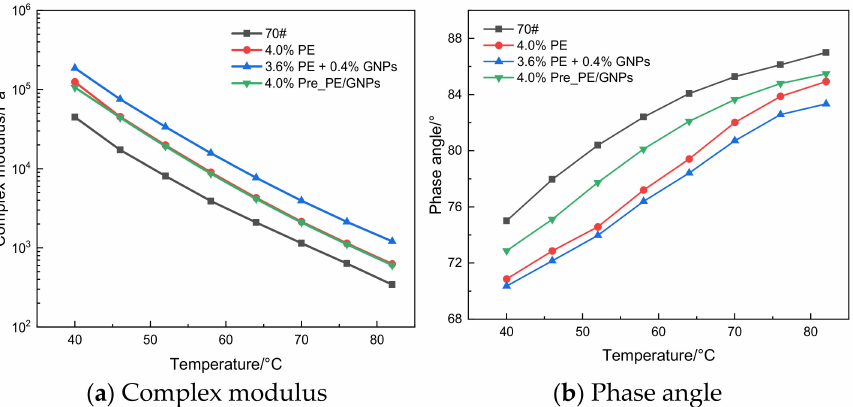
Figure 5. Variation of viscoelastic mechanical response of asphalt binders with temperature. ( a ) Com- plex modulus, ( b ) Phase